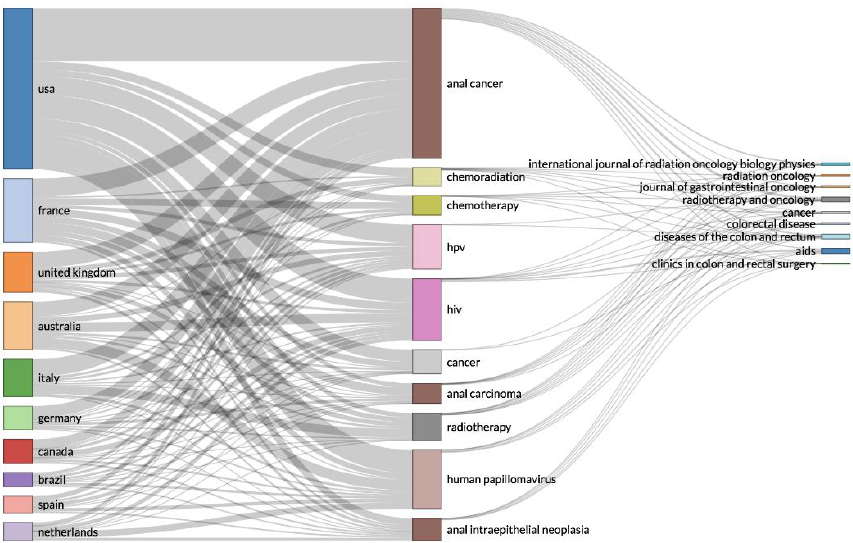
Figure 6. Three-field plot of classification by country, keyword and source from all